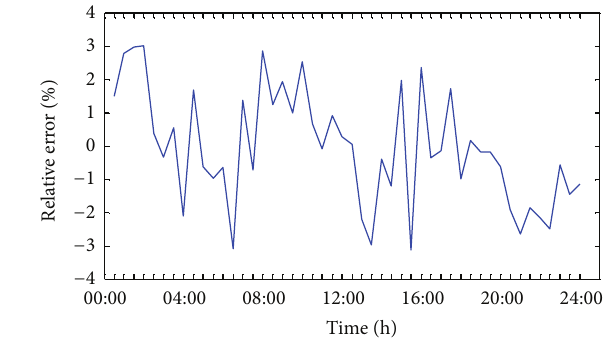
Figure 5: The relative error